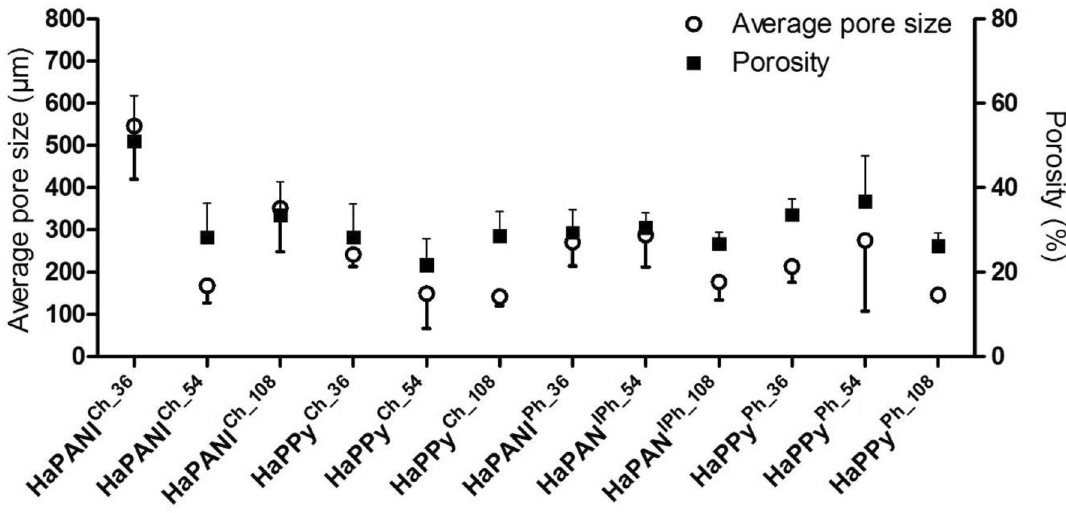
Figure 5. Average pore size and its standard deviation and average porosity and its standard deviation of the scaffolds as determined by image analysis according to ASTM E-112.